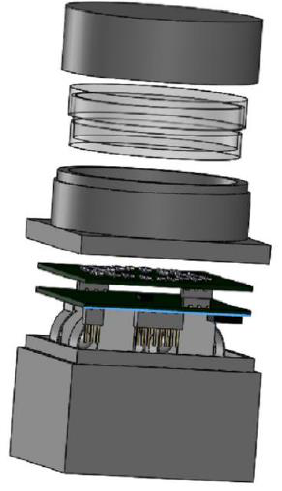
Figure 3. Design of the experimental setup for in vitro tests.